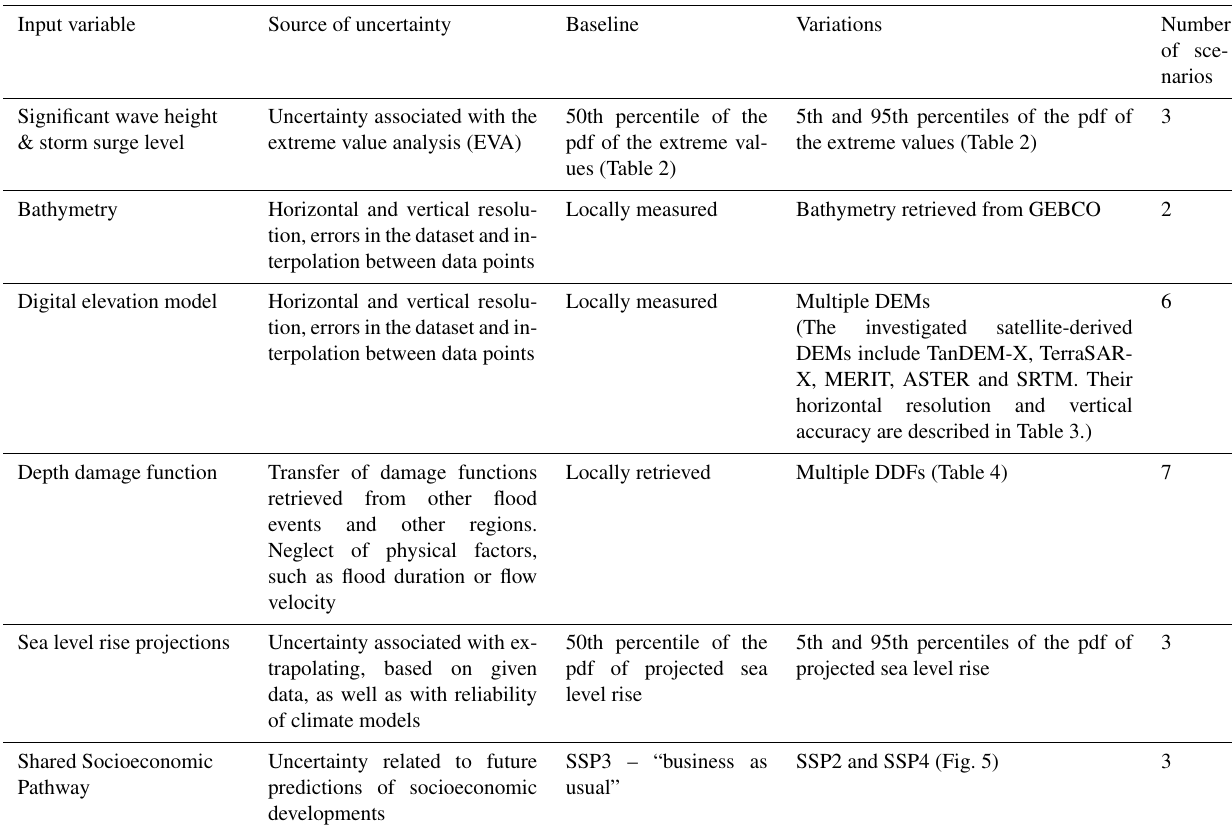
Table 1. Overview of all uncertainty sources investigated (input variable), with descriptions of their source of uncertainty, baseline value and the variations from the baseline value as used for the CFR analysis.